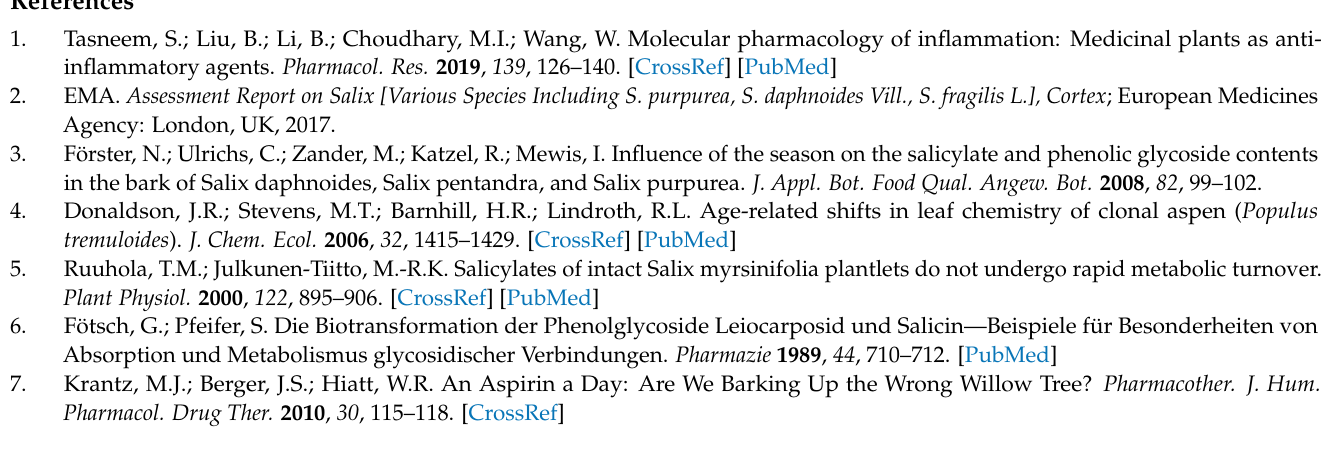
507.0 showing the fragmentation pattern of 2’,6’- O -diacetylsalicortin ( 4 ). Figure S9: Semi-preparative UV-HPLC chromatogram of fraction F6-13 at 200 nm. Figure S10: Centroided MS 2 spectrum of m / z 603.2 showing the fragmentation pattern of lasiandrin ( 5 ). Figure S11: UV-HPLC chromatogram of SPE fraction F7 at 200 nm. Figure S12: Semi-preparative UV-HPLC chromatogram of fraction F7-8 at 200 nm. Figure S13: Centroided MS 2 spectrum of m / z 527.0 showing the fragmentation pattern of tremulacin ( 6 ). Figure S14: Semi-preparative UV-HPLC chromatogram of fraction F5-2 at 252 nm. Figure S15: Centroided MS 2 spectrum of m / z 441.1 showing the fragmentation pattern of cinnamrutinose A ( 7 ). Figure S16: Absolute configuration of the isolated salicylates, 1 - 2 and 4 - 6 , substituted with a HCH moiety determined by CD-spectroscopy. Figure S17: Semi-preparative UV-HPLC ( λ = 200 nm) chromatogram of fraction F7-4. Table S1: 13 C-NMR data of 1 - 6 . Table S2: 1 H-NMR data of 1 - 6 . Table S3: Multiplicity and coupling constants of 1 - 6 . Table S4: NMR data (500/125 MHz) of 7 . Table S5: NMR data (500/125 MHz) of first diastereomer 8 (compound B) in methanol- d 4 . Table S6: NMR data (500/125 MHz) of second diastereomer 8 (compound C) in methanol- d 4 . Further materials regarding the isolation and identification (UV, MS, NMR, and CD data) of the bioactive substances can be found in the Supplementary